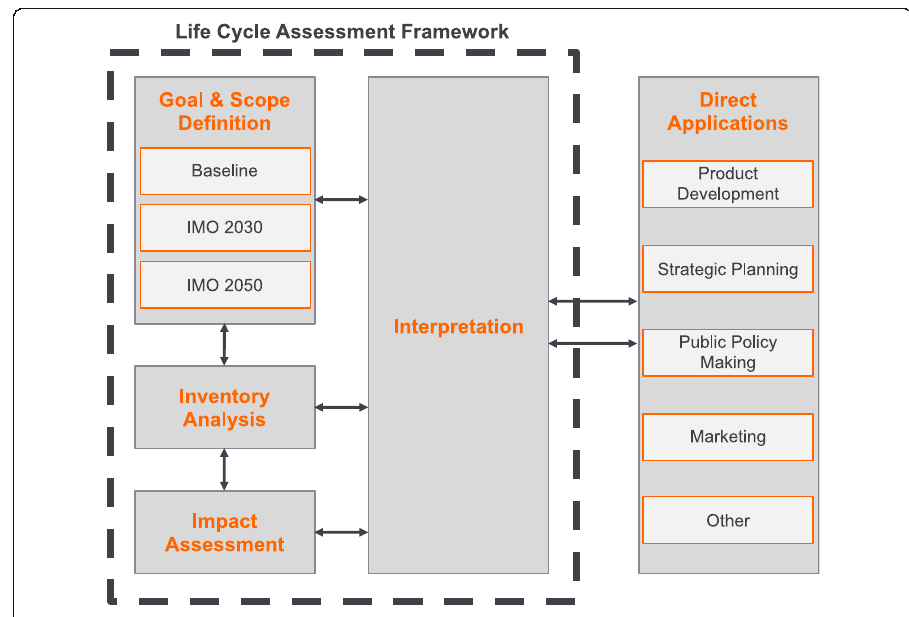
Fig. 2 Standardized Life Cycle Assessment Framework (Based on Joules n.d.-b,